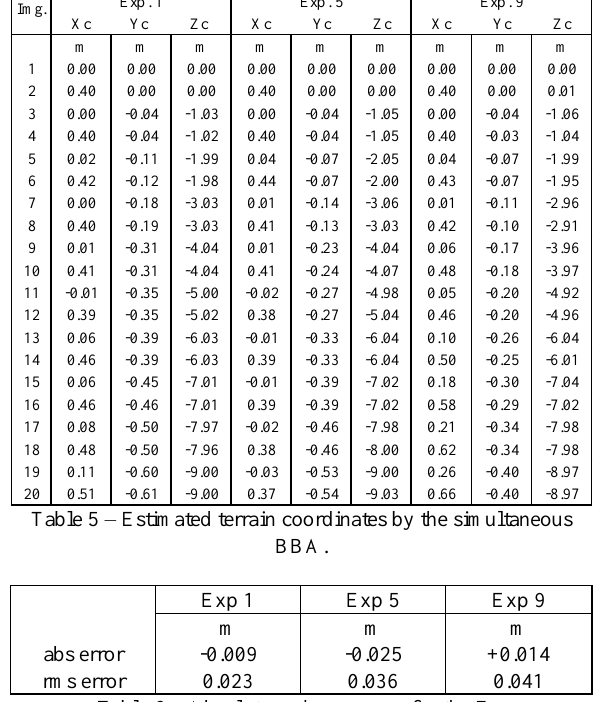
Figure 6 – Estimated positions of the PC plotted in the LACRF after BBA Exp